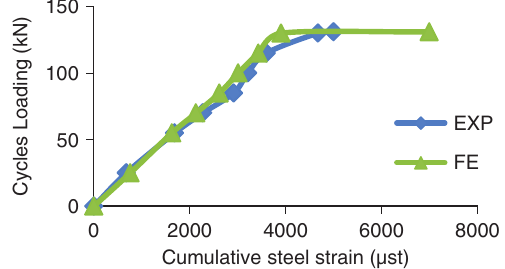
Fig. 17. Load against steel strain curves for pre-repair phase of the beam G3R2